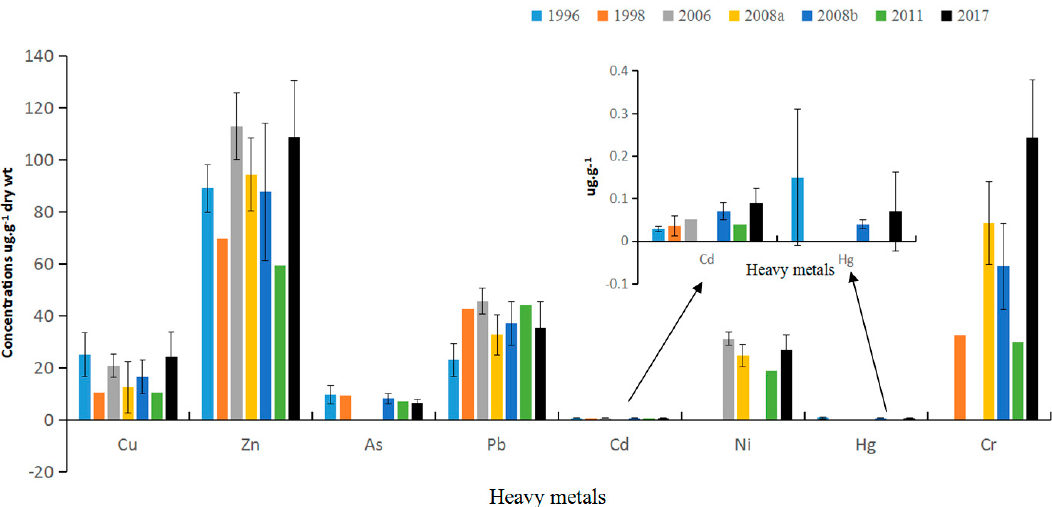
Figure 2. Comparison of mean concentrations of heavy metal in the present study in 2017 with those of previous years. Data of 1996, 1998, 2006, 2008a, 2008b, 2011 were referenced from [15,20–24], respectively.